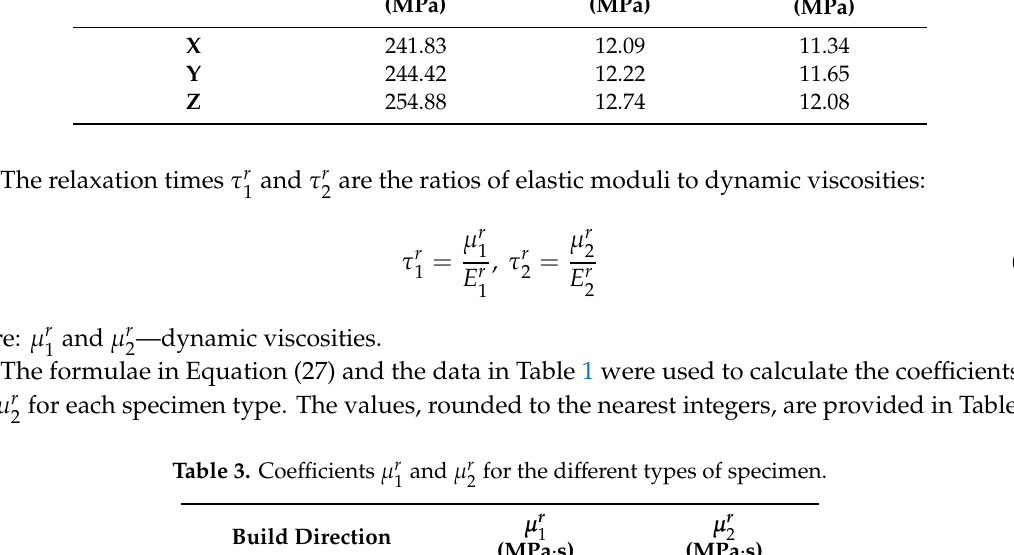
Table 3. Coe ffi cients µ r